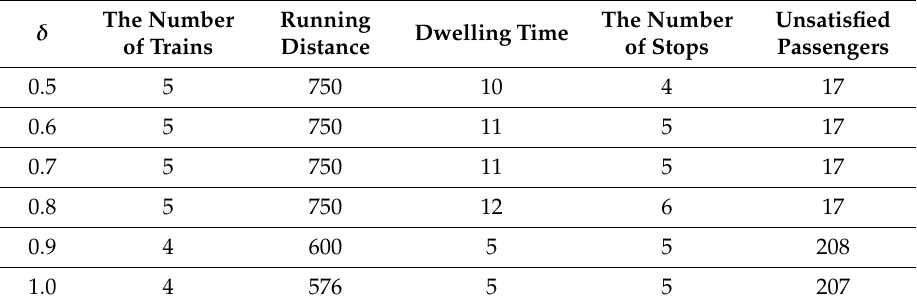
Table 7. Optimized solutions obtained under di ff erent capacity-occupancy ratio δ .